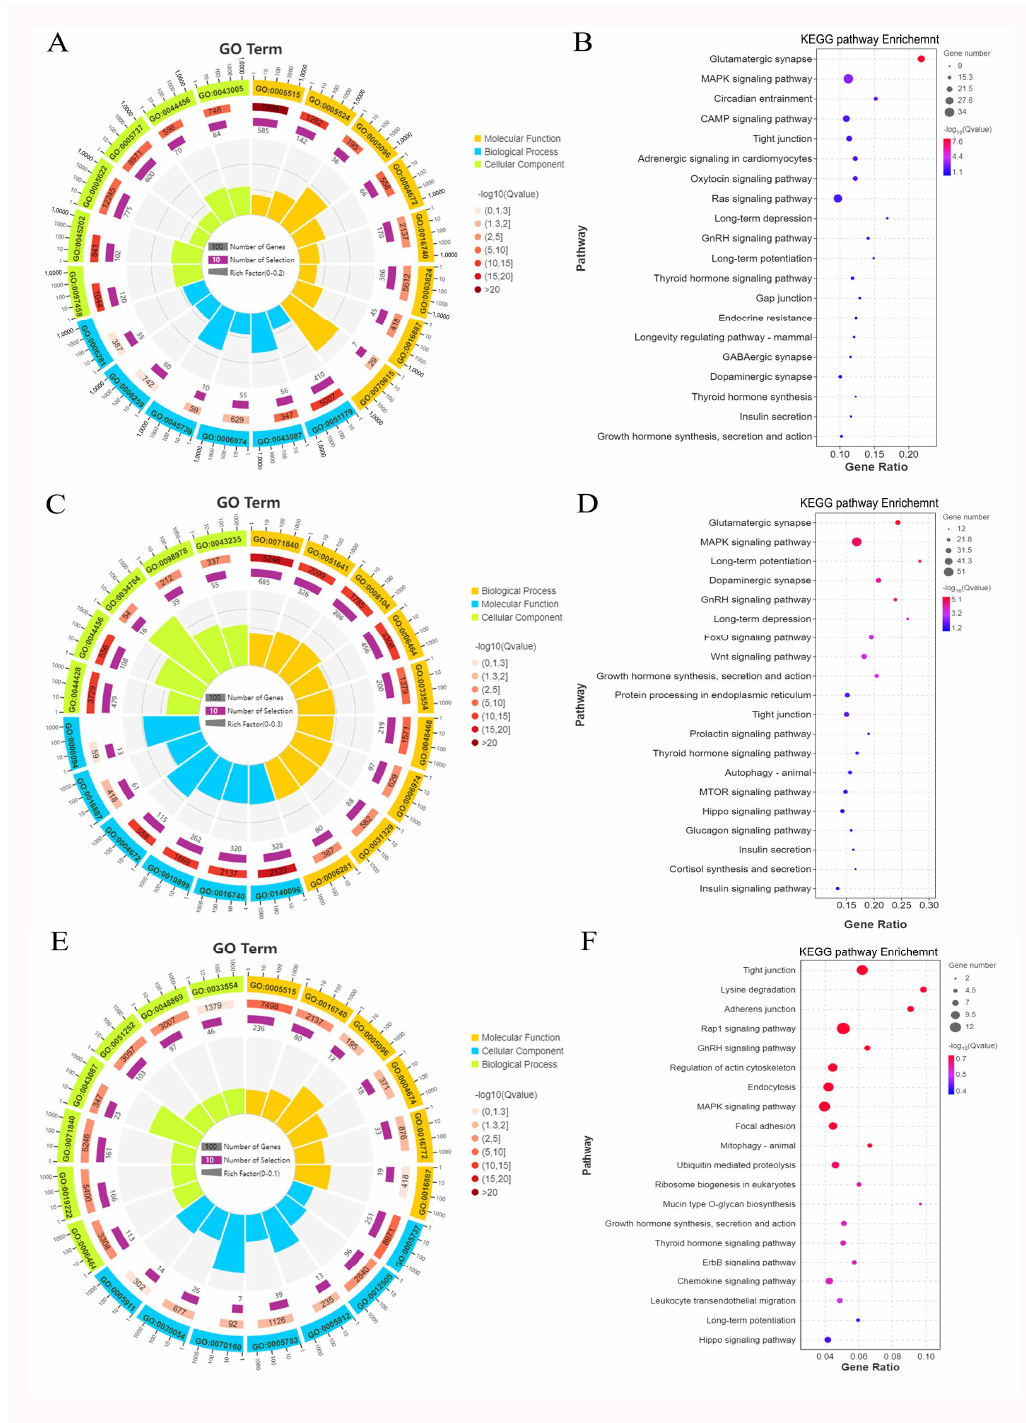
Figure 5. GO functional enrichment and KEGG pathway analysis on the source genes of DEcircRNAs in the hypothalamus ( A , B ), pituitary ( C , D ), and mammary gland ( E , F ) in dairy cows under heat stress.